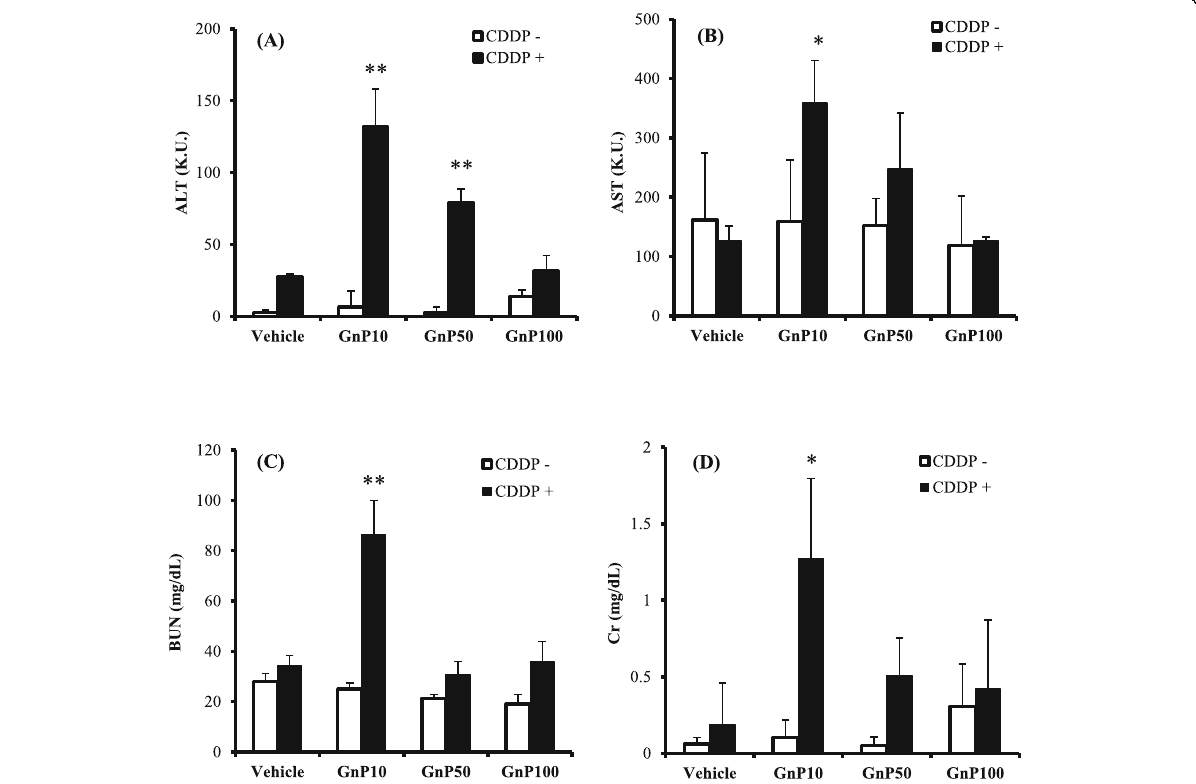
Fig. 2 Effect of gold nanoparticles on cisplatin-induced toxicity. Mice were injected intraperitoneally with cisplatin (CDDP) at 0 (open bars) or 100 μ mol/kg (solid bars), together with an IV injection of vehicle or gold nanoparticles (4 mg/kg). At 24-h post-injection, serum levels of the liver enzymes alanine aminotransferase (ALT; panel a ) and aspartate aminotransferase (AST; panel b ), and plasma levels of blood urea nitrogen (BUN; panel c ), and creatinine (Cr; panel d ) were determined using commercially available kits (see “ Biochemical analyses ” section). Data are presented as mean ± standard error of the mean (SEM; n = 4). Significant difference (* P < 0.05, ** P < 0.01) between vehicle- and CDDP-treated